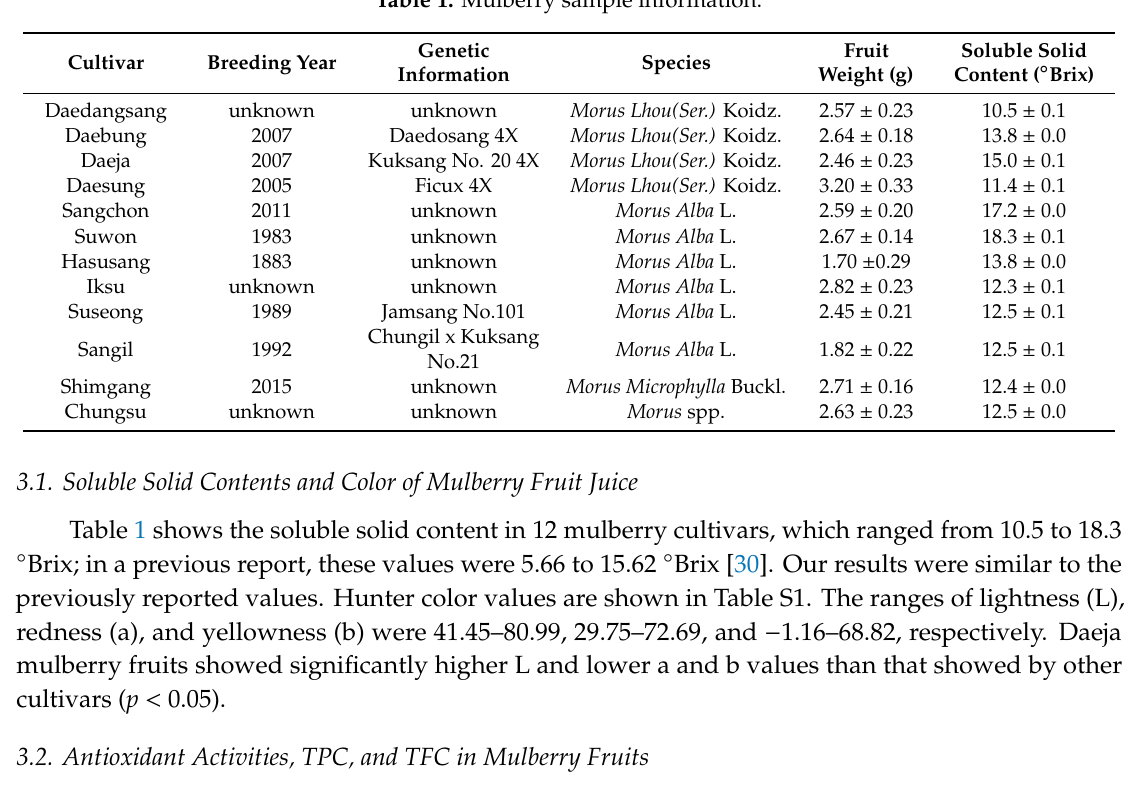
Table 1. Mulberry sample information.